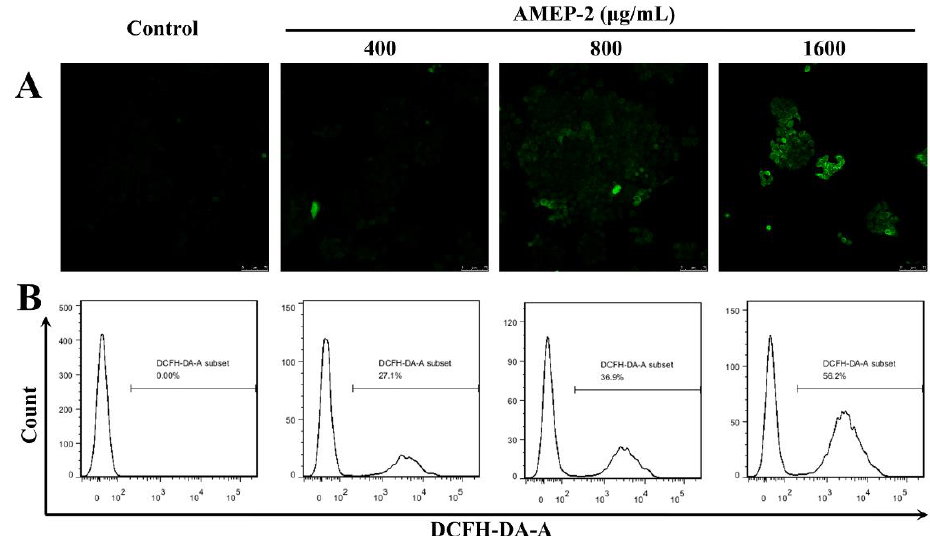
Figure 7. Effect of AMEP-2 on ROS production in BGC-823 cells: ( A ) Effect of AMEP-2 on ROS production in BGC-823 Cells by Immunofluorescence; ( B ) Effect of AMEP-2 on ROS production in BGC-823 Cells by Flow cytometry.